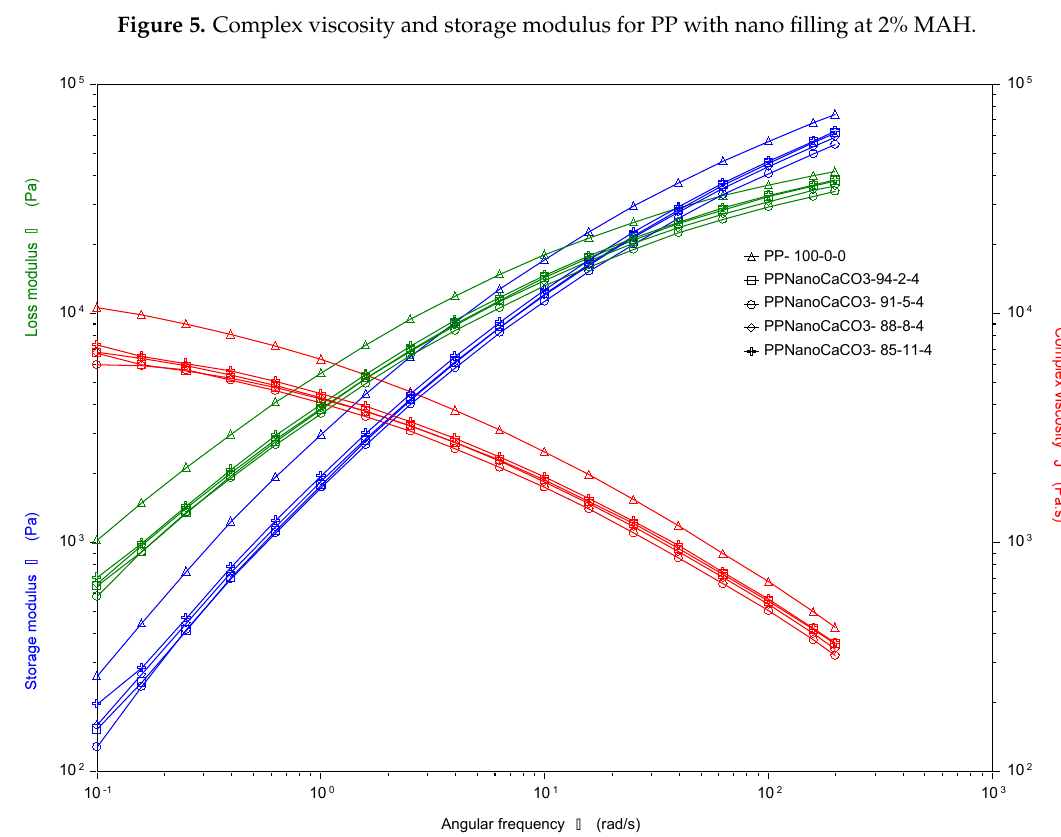
Figure 6. Complex viscosity and storage modulus for PP with nano filling at 4% MAH.